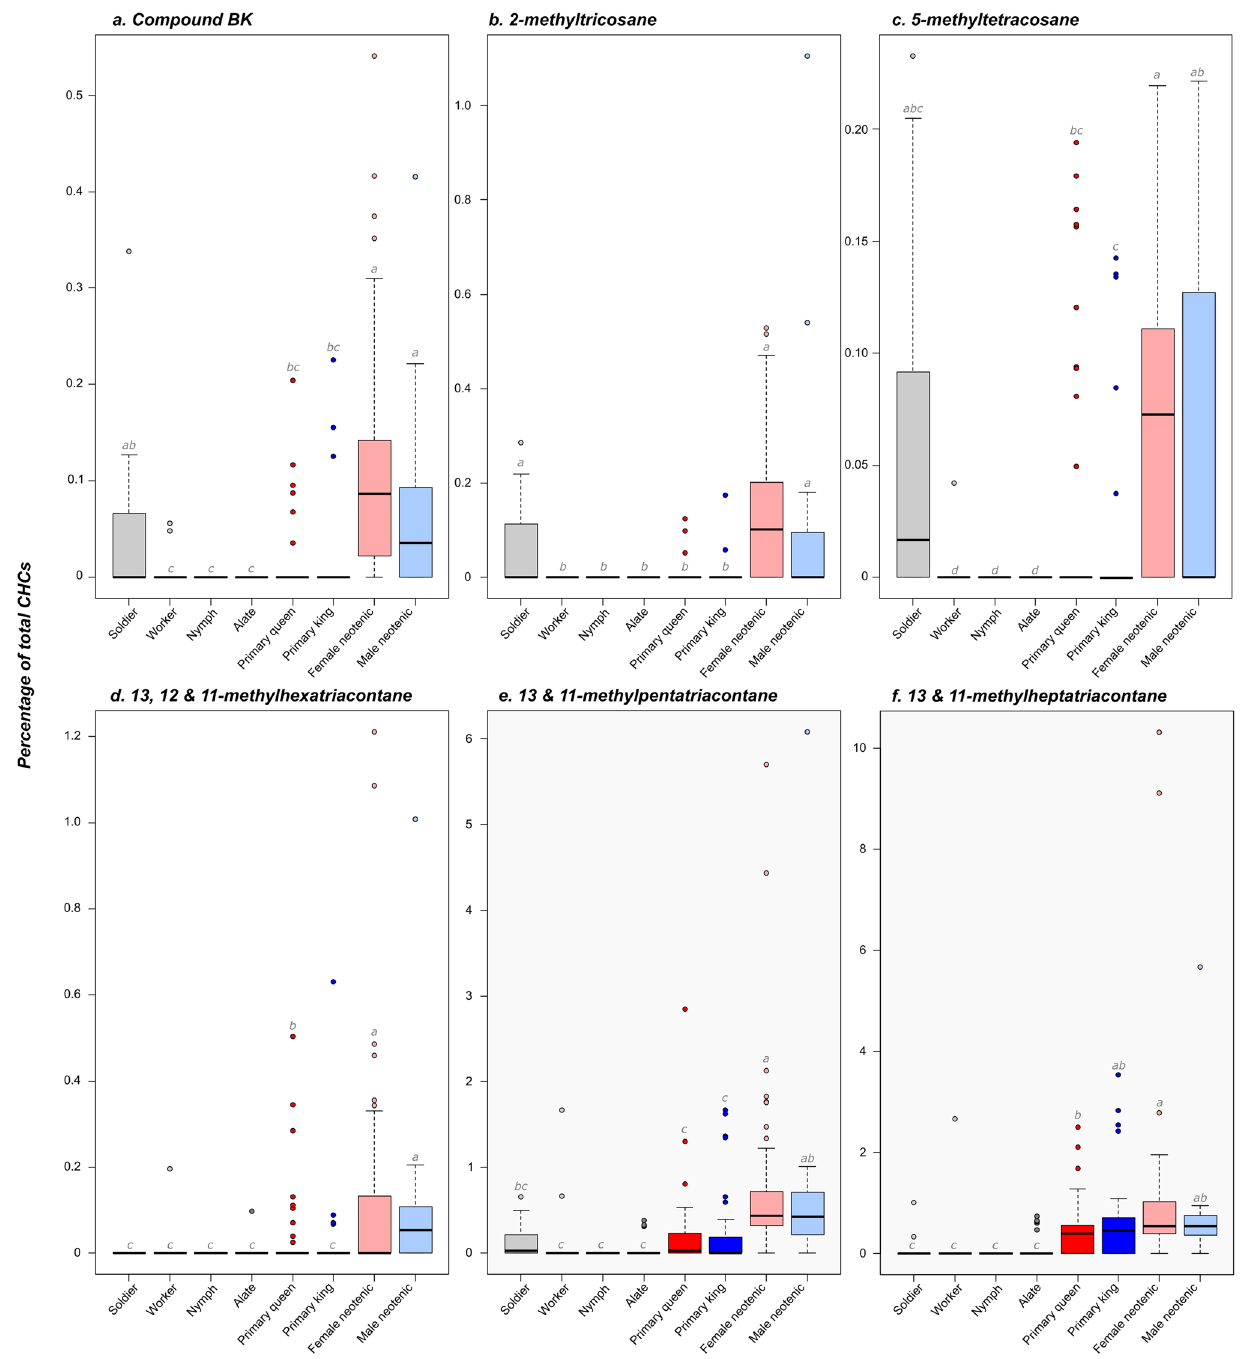
Figure 2. Representation for different castes and sexes of the relative proportion of the six additional compounds potentially used as royal pheromones by the male and female neotenics of Reticulitermes flavipes ( a Compound BK; b 2-methyltricosane; c 5-methyltetracosane; d 13, 12 and 11-methylhexatriacontane; e 13/11-methylpentatriacontane; f 13, 12 and 11-methylheptatriacontane) . Box plots represent median and 1st and 3rd quartile; whiskers include 95% of all observations; individual dots show outlier values. Different lower case letters indicate significant differences between groups. Dark red markers represent primary queens, dark blue represent primary kings, light red markers represent female neotenics and light blue represent male neotenics. Non-reproducing castes (soldier, worker, nymph and alate) are depicted in